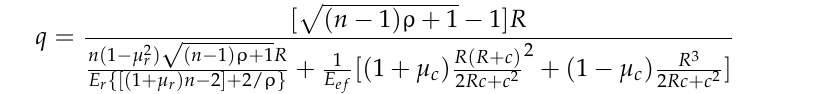
Figure 2. Corrosion process of the concrete. ( a ) First stage of corrosion; ( b ) Second stage of corrosion; ( c ) Third stage of corrosion.